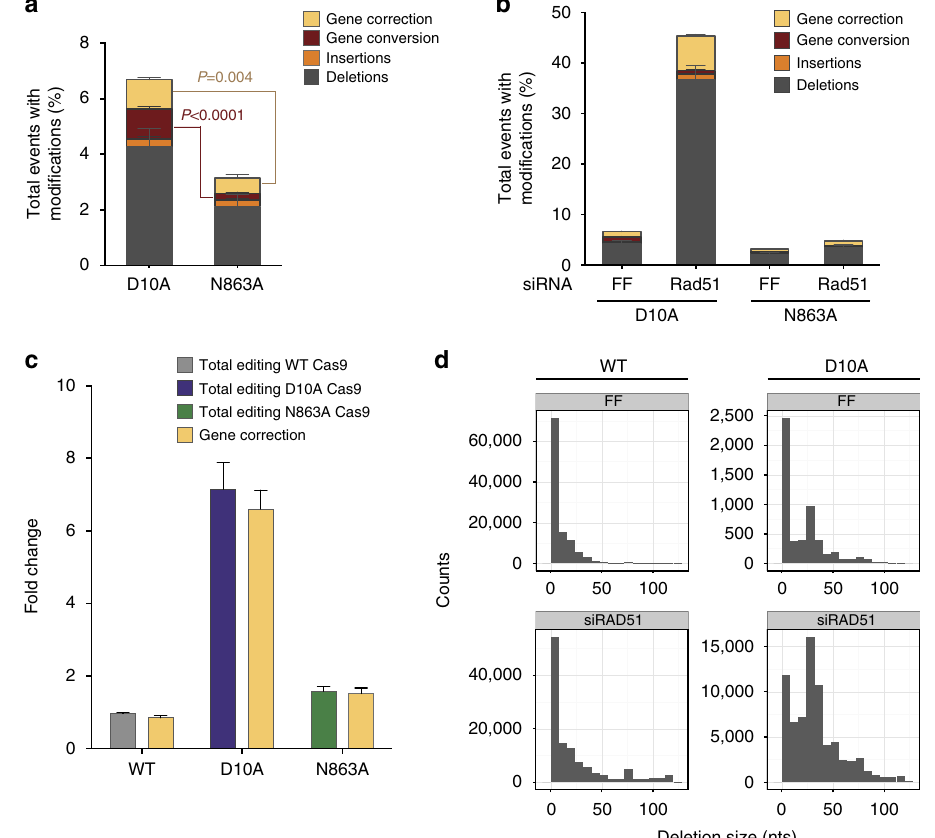
Figure 6 | Characterization of repair pathway engagement of Cas9 variant-induced single nicks. ( a ) Frequency of deletions, insertions, gene conversion and gene correction (using the ‘high mismatch ssODN’) from U2OS cells nucleofected with D10A Cas9 and N863A Cas9 and gRNA 8. Sequencing was performed using an Illumina MiSeq and modifications were quantified computationally (Methods). Three independent experiments. The P values for the difference in gene correction and gene conversion frequency was calculated using the two-tailed Student’s t -test. Data are represented as mean ± s.e.m. ( b ) Frequency of deletions, insertions, gene conversion and gene correction (using the ‘high mismatch ssODN’) observed after U2OS cells were nucleofected with WT, D10A, or N863A Cas9 and gRNA 8, and an siRNA against RAD51 or firefly luciferase (FF) control. Sequencing was performed using an Illumina MiSeq and modifications were quantified computationally using (Methods). Three independent experiments. Data are represented as mean ± s.e.m. ( c ) Bar graph of fold change in the rates of total editing events and gene correction (using the ‘high mismatch ssODN’) for the D10A and N863A Cas9 mutants of cells treated with and siRNA against RAD51 relative to FF treated control. Three independent experiments. Data are represented as mean ± s.e.m. ( d ) Representative histogram of the length of WT Cas9 and gRNA 8 or D10A Cas9 and gRNA 8-induced deletions in the presence or absence of